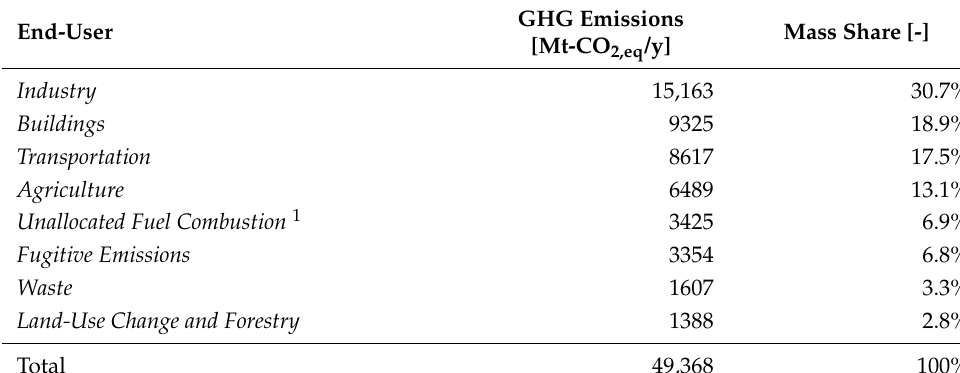
Table 2. World GHG emissions (2018) shared among end-users (data from [3,7]).